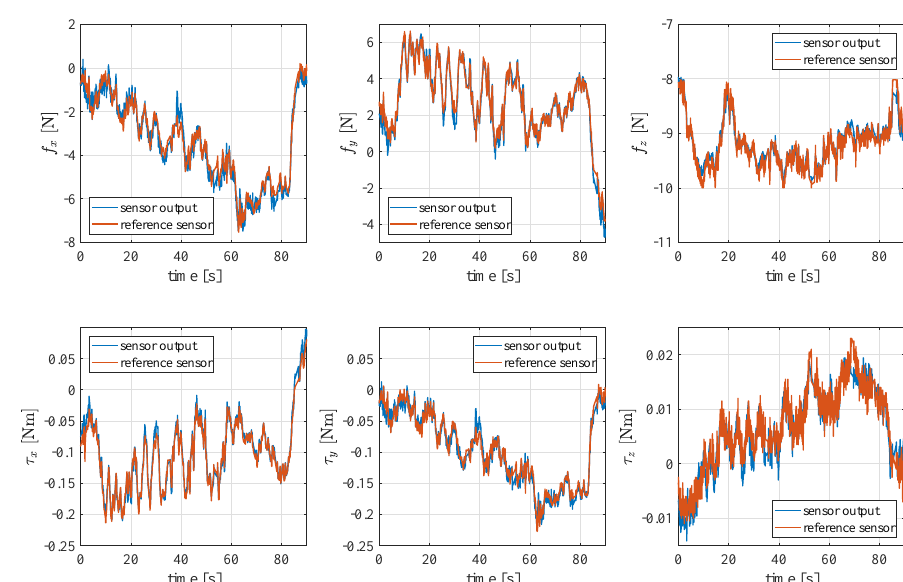
Figure 13. Result of the feed-forward neural network (FF-NN) fitting on the whole acquired training set before